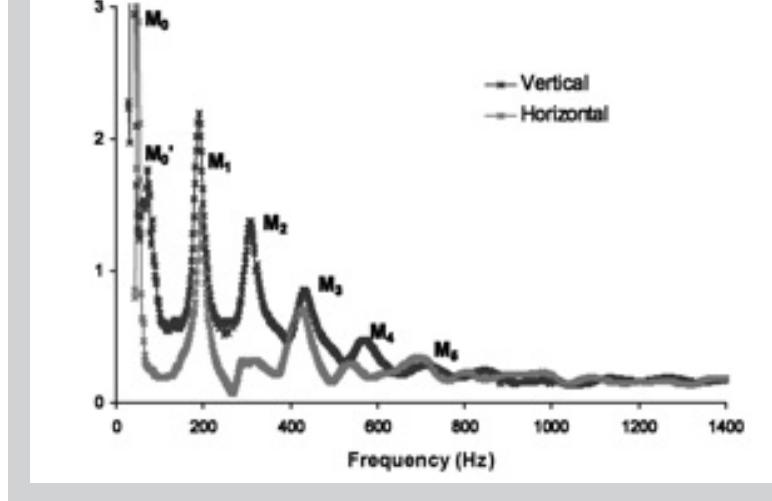
Figure 4: The AFPs from Fig. 2 after corrections. Relative ampli- tude is expressed in natural scale and corrected using Eq. 6a and b for vertical and horizontal laser positions, respectively. M for corrections (f was 38.15 and 51.88 Hz for vertical and horizontal posi-